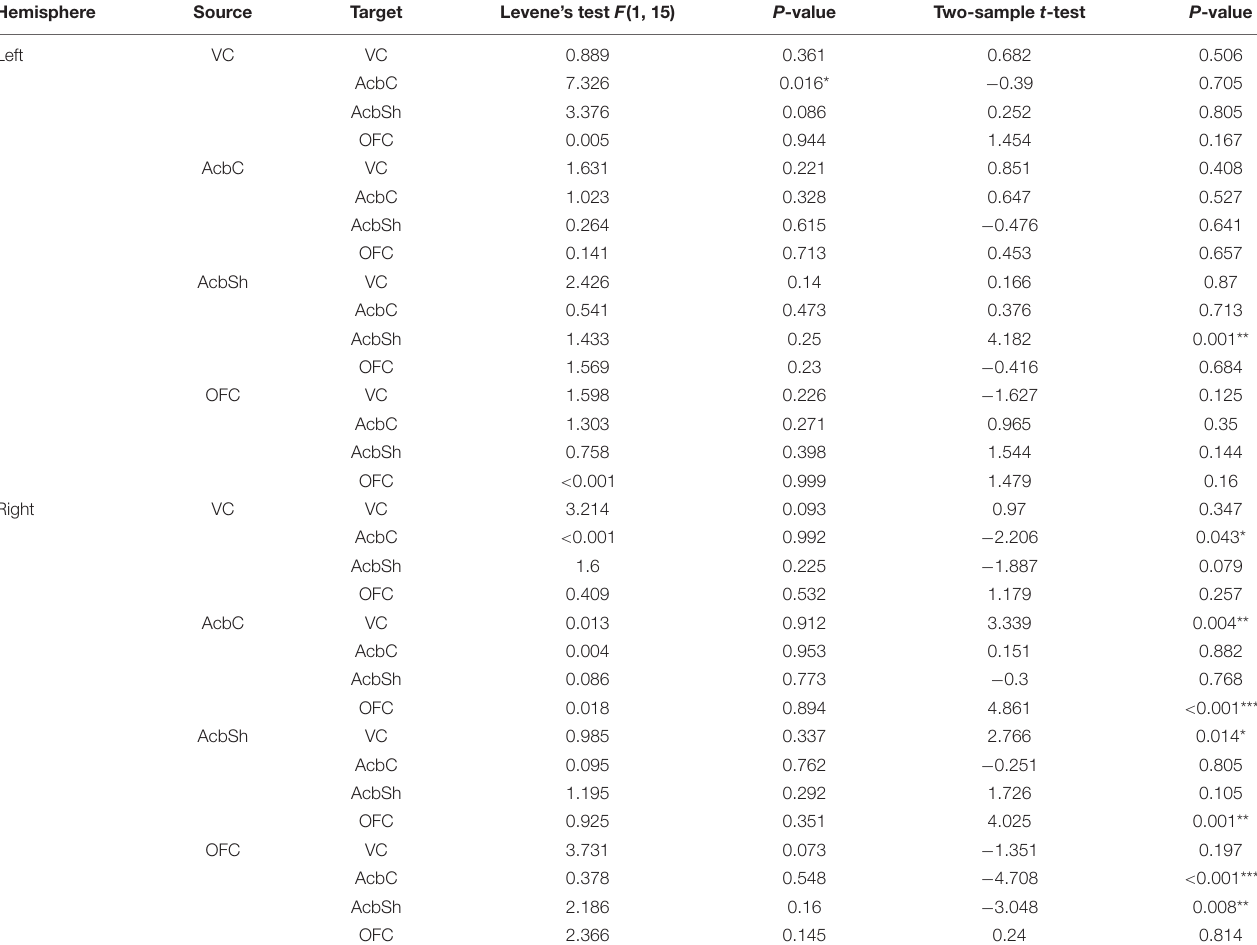
TABLE 2 | Comparisons of EC between MAM-rTMS and MAM-sham groups. Hemisphere Source Target Levene’s test F (1,